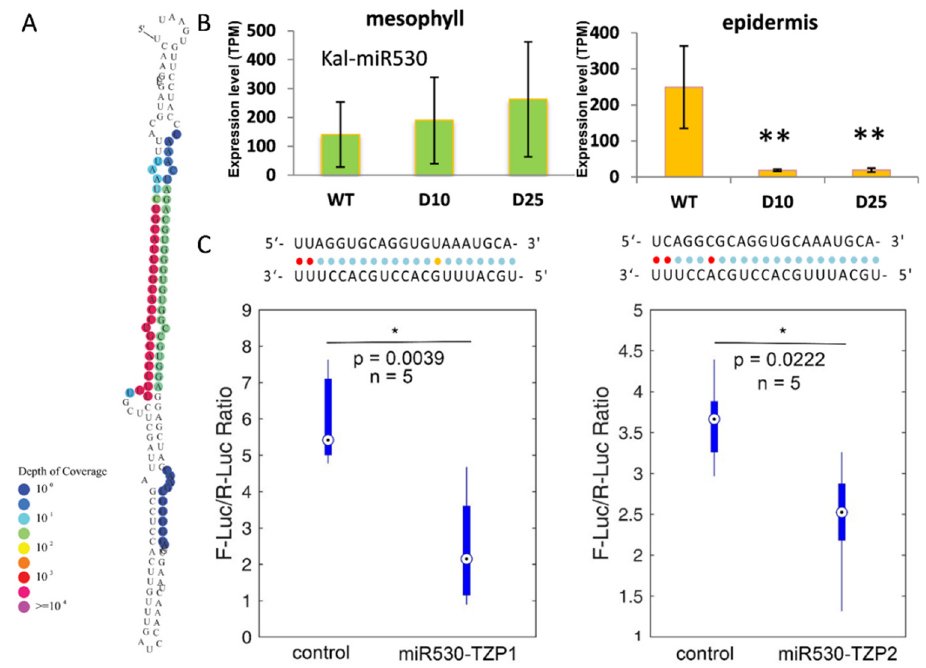
Figure 4. miR530 targets Km TZP1 and Km TZP2 in K. marnieriana . ( A ) Secondary structure of miR530 precursor in K. marnieriana . Different colors indicate the depth of coverage of small RNA sequencing reads that are mapped to the precursor as described before. ( B ) Expression of miR530 mature sequences in epidermis (orange) and mesophyll (green) under the drought treatments. Three biological replicates are used for each quantification and statistical analysis. The Student’s test is performed. Stars indicate significant differences (** indicates p -value < 0.01). TPM, Transcripts Per Kilobase of exon model per Million mapped reads. ( C ) Verification of target sites of miR530- TZP1 (left) and miR530- TZP2 (right) by the dual-luciferase assay. For each combination of verification, five replicates are used for inoculation as described [31]. The Student’s test is performed. A star indicates significant differences (* indicates p -value < 0.05; ** indicates p -value < 0.01) .